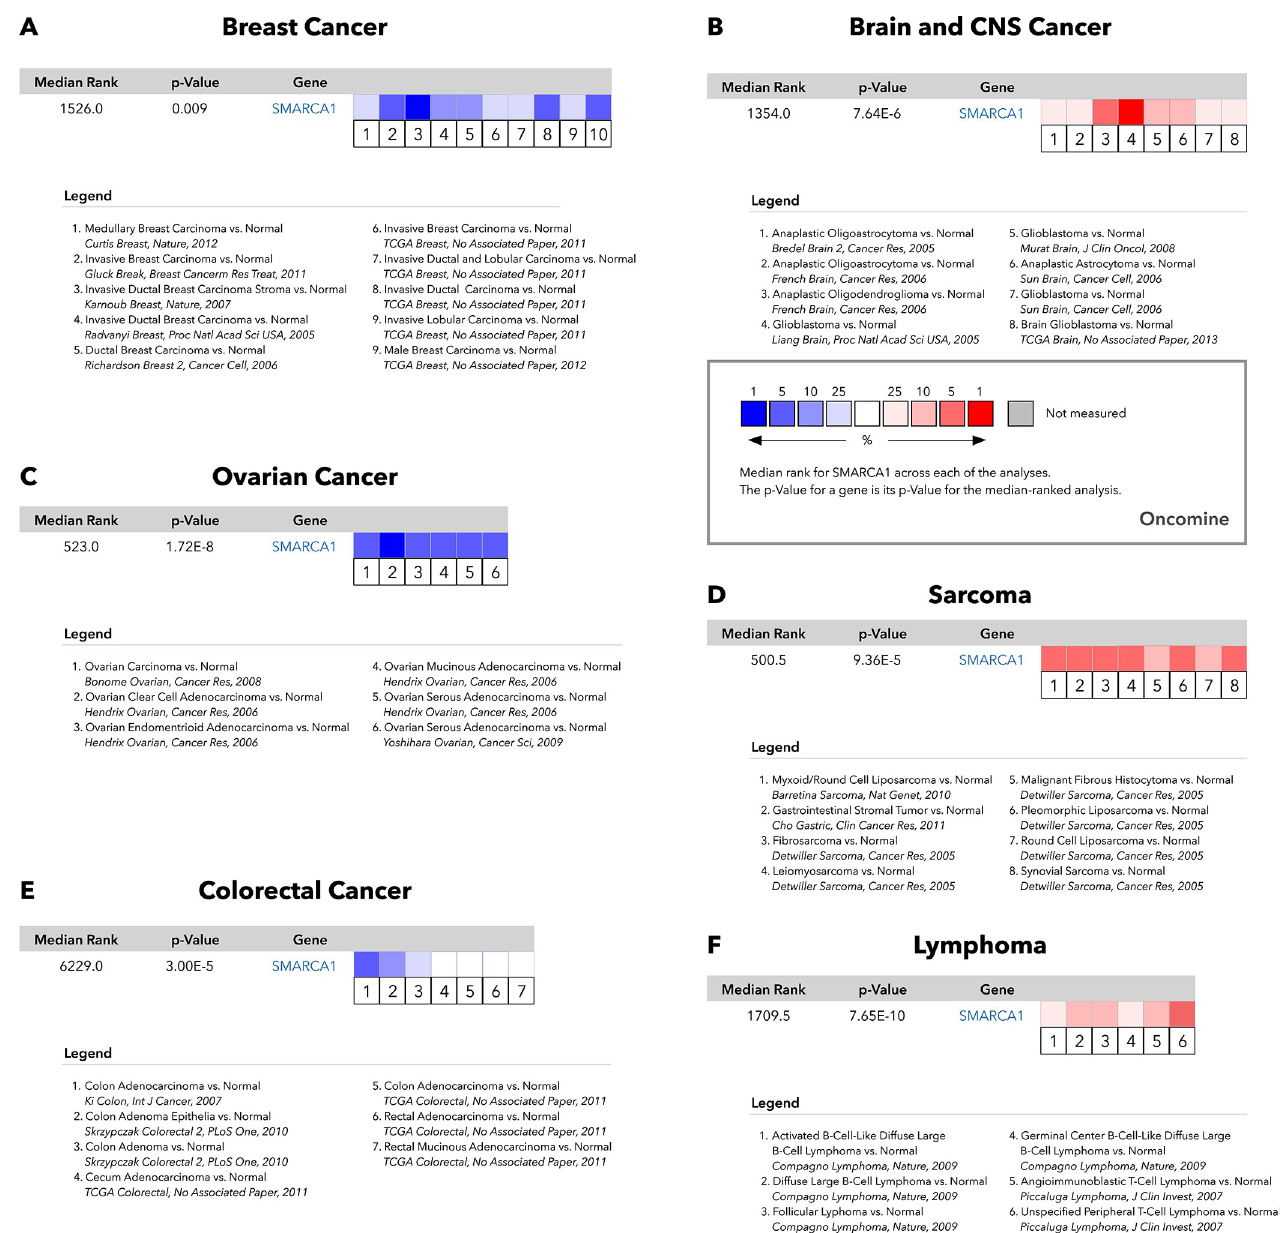
Fig 3. Pooling analysis of the difference in SMARCA1 expression between tumor and normal tissues via the Oncomine database. (A) Breast cancer; (B) Brain and CNS cancer; (C) Ovarian cancer; (D) Sarcoma; (E) Colorectal cancer; (F) Lymphoma.